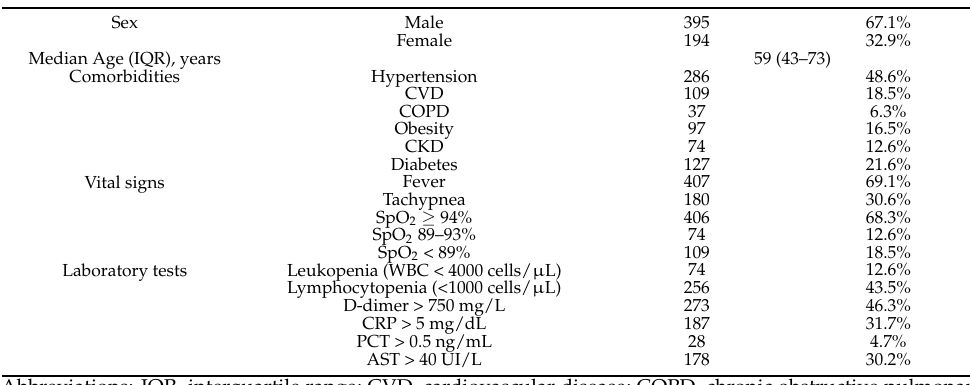
Table 1. Baseline characteristics of the patients admitted at the “Garibaldi” Hospital in Catania